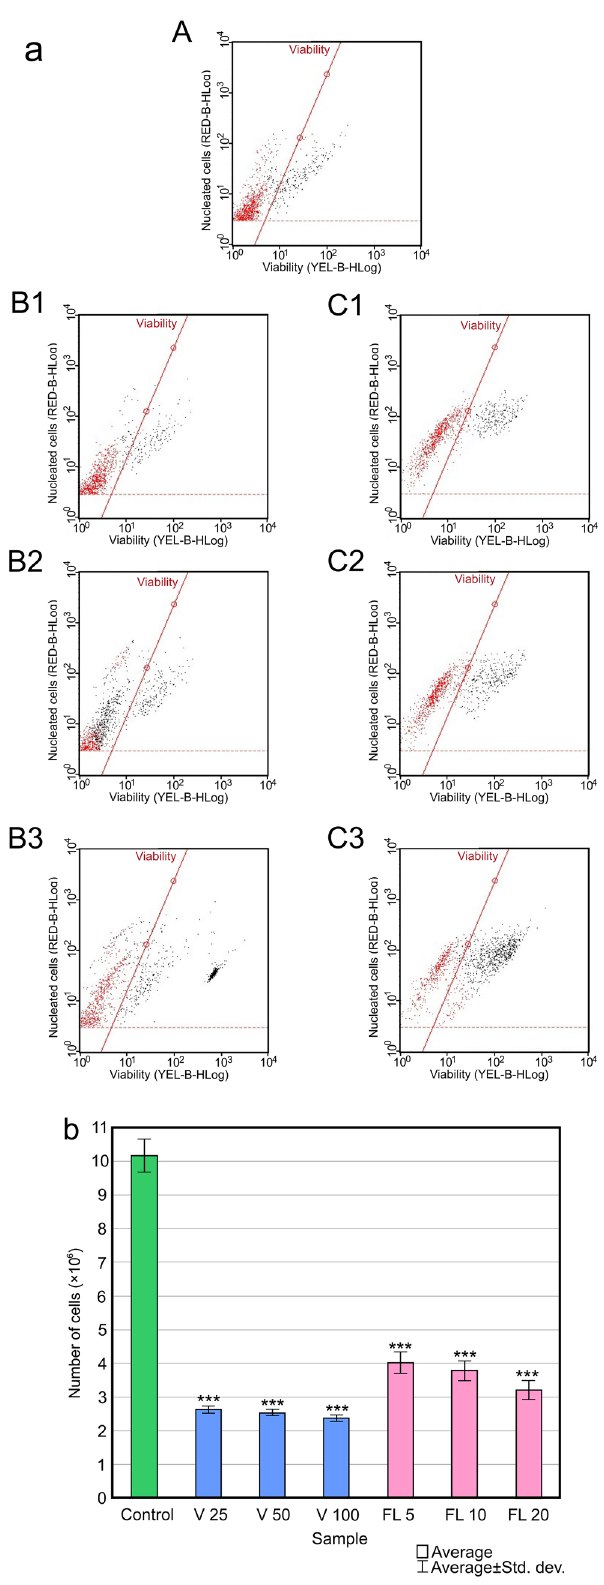
Figure 9. ( a ) Flow cytometry data of C. albicans cell cultures: ( A )—control cell culture; ( B1 )—cell culture treated with Venetin-1 at 25 µg mL −1 , ( B2 )—with Venetin-1 at 50 µg mL −1 , ( B3 )—with Venetin-1 at 100 µg mL −1 ; ( C1 )—cell culture treated with fluconazole at 5 µg mL −1 ; ( C2 )—with fluconazole at 10 µg mL −1 , ( C3 )—with fluconazole at 20 µg mL −1 . The red color corresponds to viable cells and the black color indicates apoptotic cells. ( b ) total number of cells in the cultures. Control— control C. albicans cells; V25, V50, V100— C. albicans cells treated with Venetin-1 at 25, 50, 100 µg mL -1 ; FL5, FL10, FL20— cells treated with fluconazole at 5, 10, 20 µg mL −1 ; *** P < 0.01 (HSD Tukey